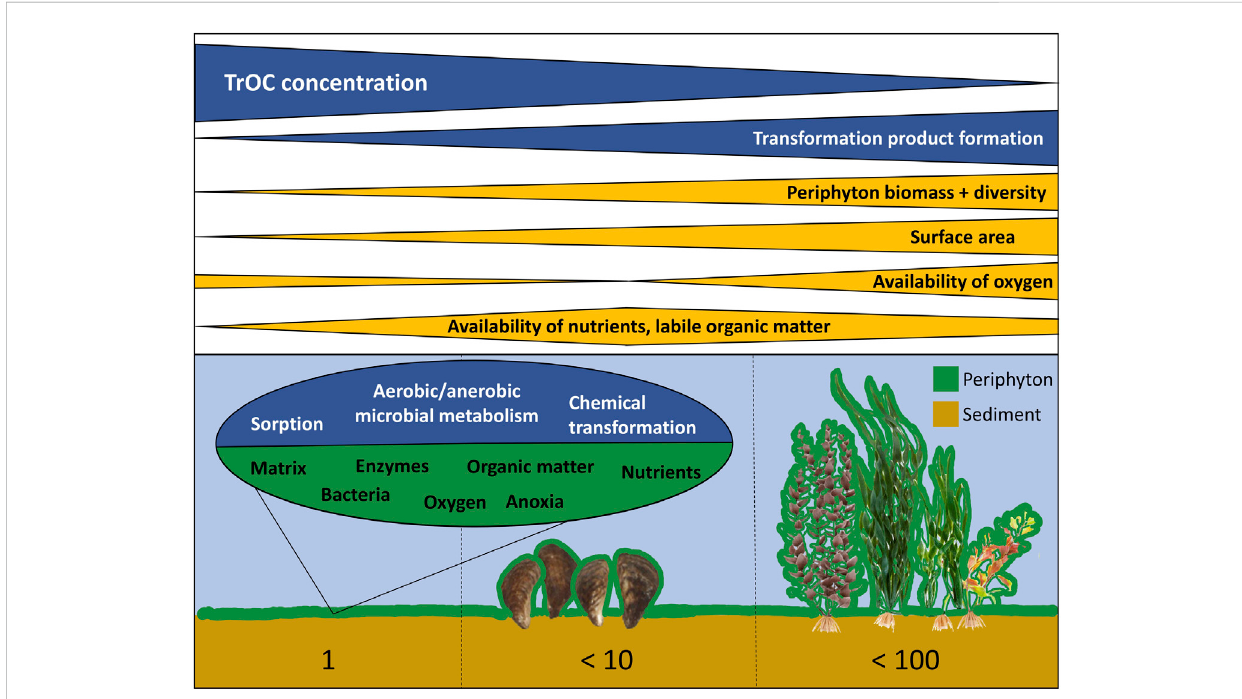
FIGURE 8 Potential mechanisms explaining effects of periphyton growing on sediment (left), mussels (middle) and submerged macrophytes (right) on trace organic compound (TrOC) transformation in surface water bodies. Numbers below indicate the increase in surface area for available periphyton growth relative to plain sediment